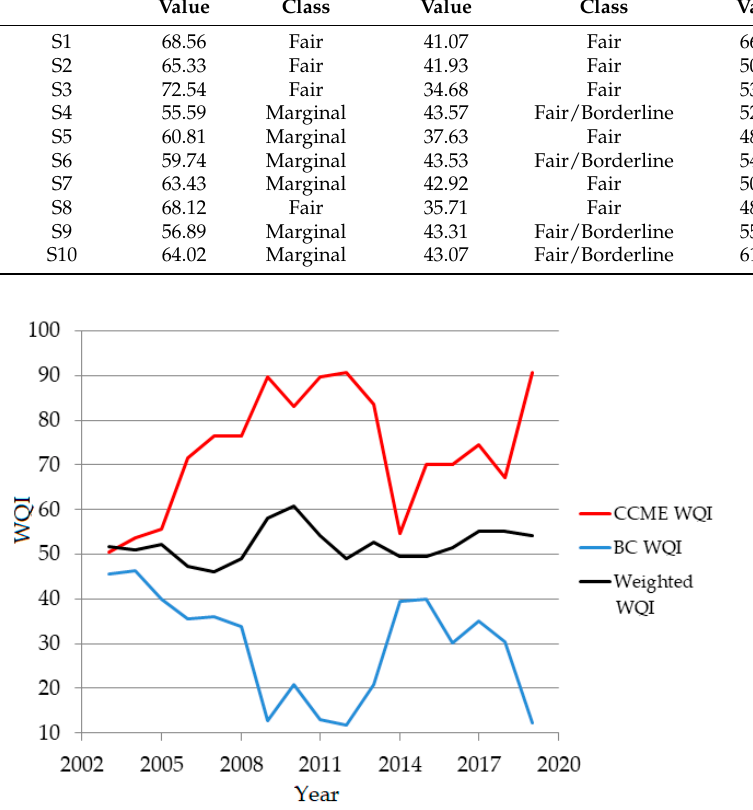
Figure 5. Water quality indexes computed for yearly series.